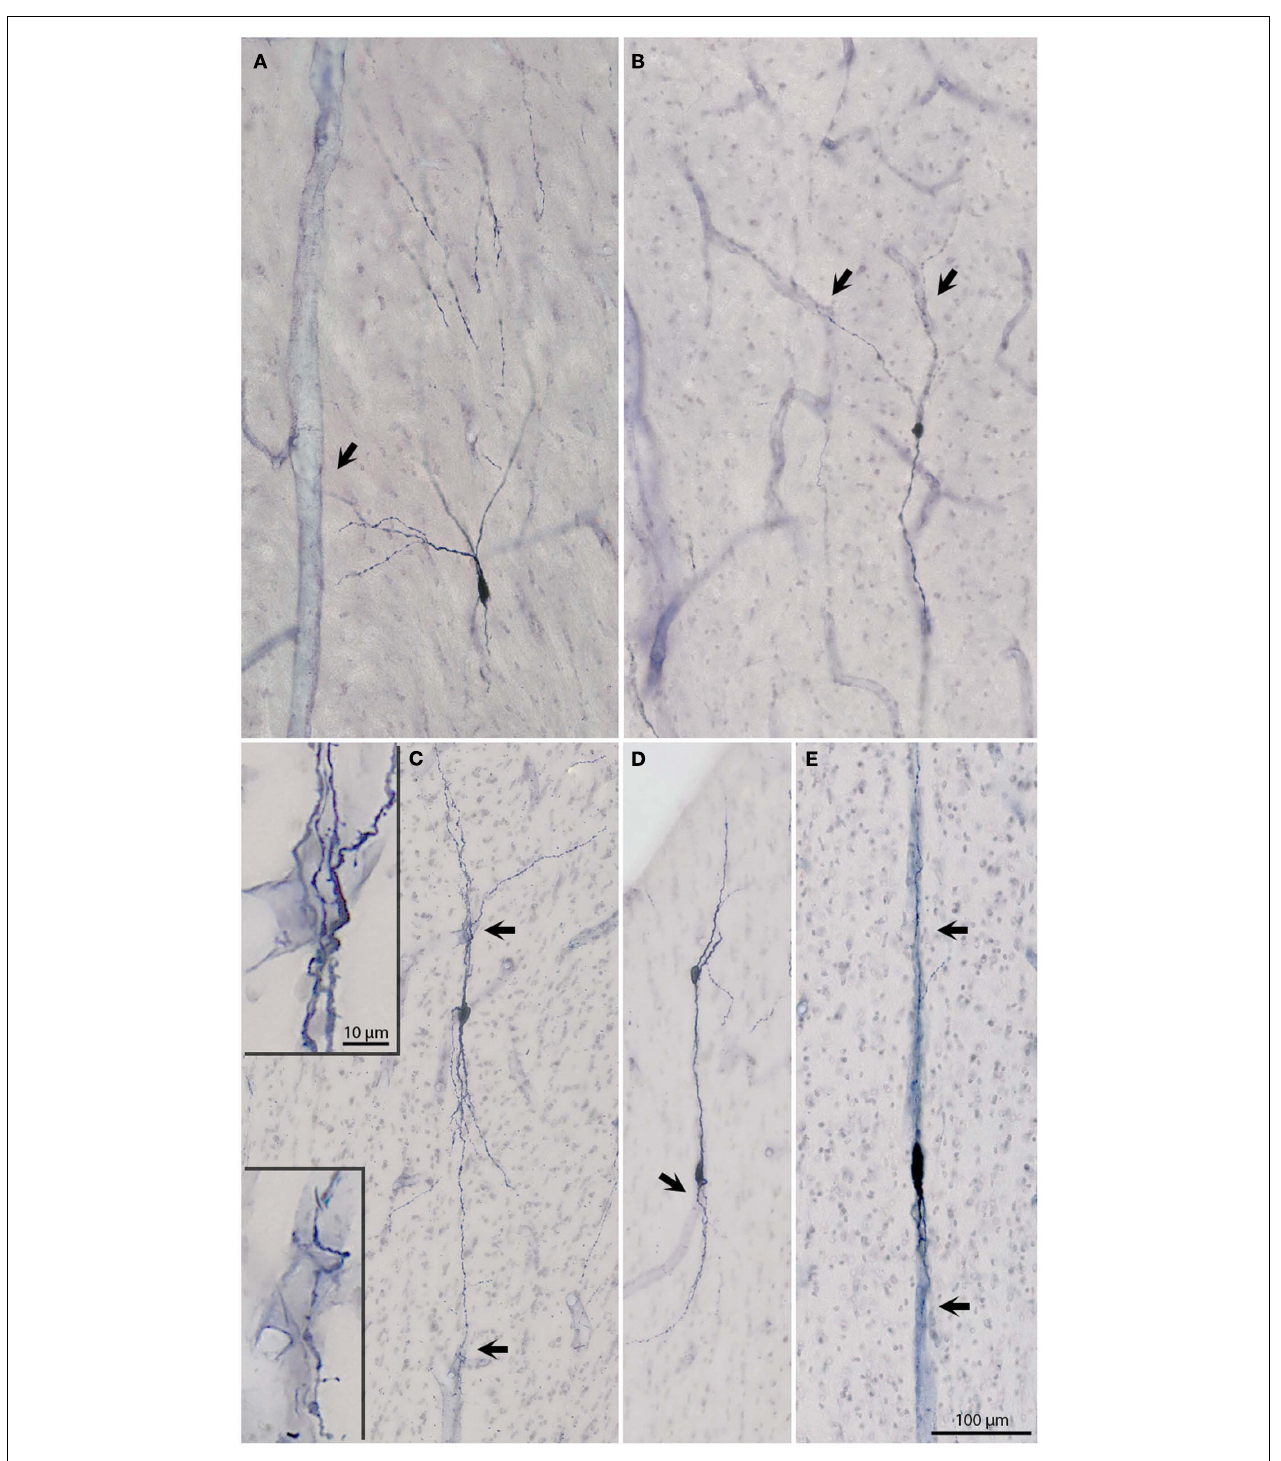
spines are evident on both segments.The two vertically aligned neurons in (D) , have partially overlapping dendrites, giving an illusory appearance of being conjoined.The neurons in (D) are from the posterior most x in Figure 1 ; the other four neurons are from R19L (A) , R31 (B) , and R30 (C,E)